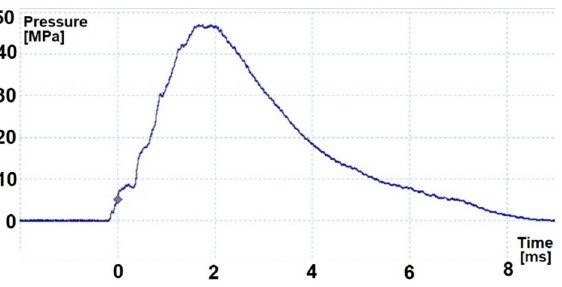
Figure 2. Example of pressure p ( t ) in the tube of a 60 mm mortar during firing.